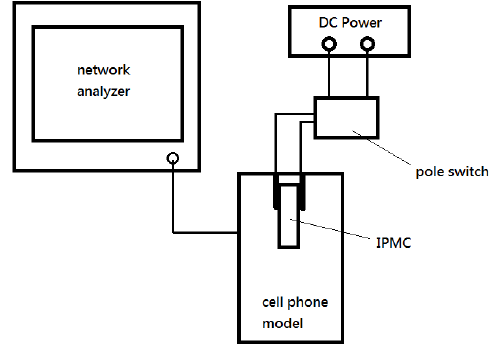
Figure 10. Schematic diagram of operation frequency and return loss measured by network